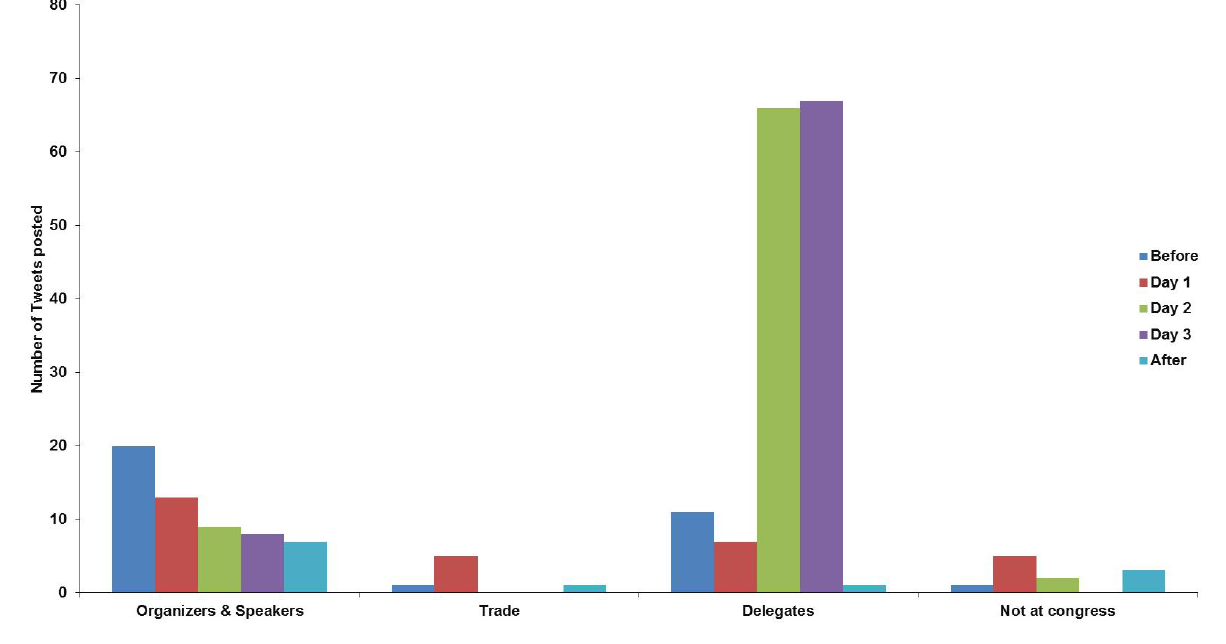
Figure 2. Pattern of tweets posted by the various groups of tweeters stratified by timing of the tweets. Each group is subdivided to show how many tweets they posted before the conference (Before), on which of the 3 days during the conference (day 1, day 2, and day 3), and after the meeting